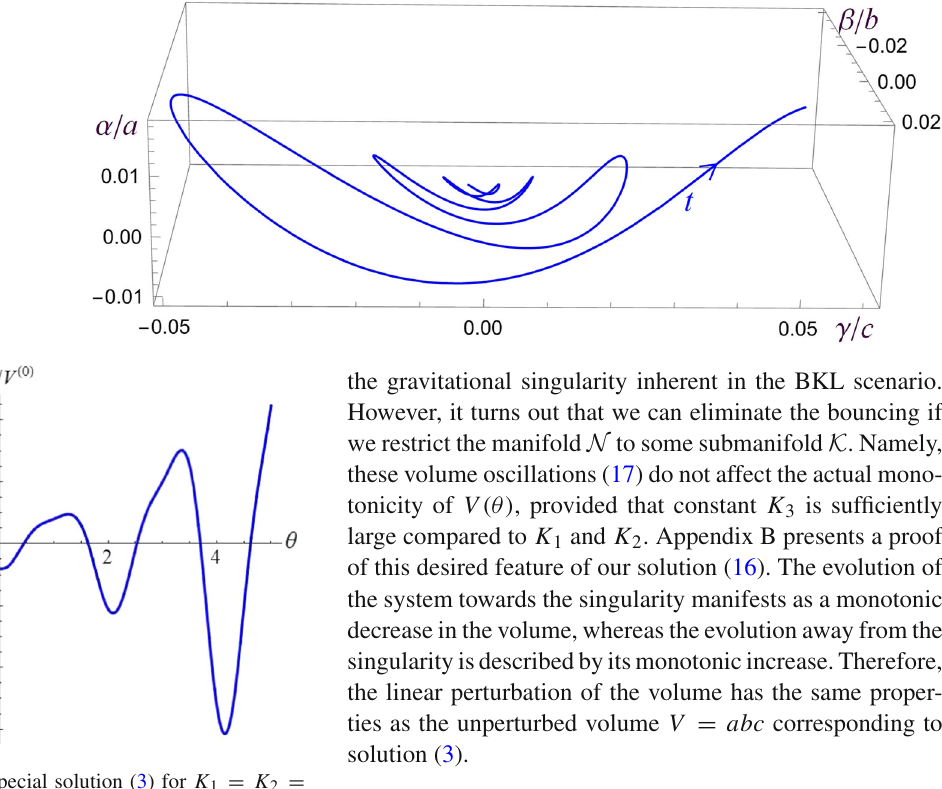
Fig. 3 Linear instability of the special solution (3) for K 1 = K 2 = 0 . 01 , K 3 = 0 , ϕ 1 = ϕ 2 = 0. The graph shows the oscillations of the relative space volume perturbation V ( 1 ) / V ( 0 ) as a function of θ = ln | t − t | , without taking into account the accompanying uniform 0 expansion. The amplitudes of the two-frequency oscillations system- atically increase as exp (θ/ 2 ) = | t − t 0 | 1 / 2 in the evolution towards the gravitational singularity ( t → ∞ ). The time interval shown in the graph corresponds to the range of applicability of the linear approxi- mation, where α, β, γ , and V ( 1 ) remain small fractions of a , b , c , and V ( 0 ) , respectively. The non-physical bouncing of the volume may be overcome by introducing a non-zero, sufficiently large K